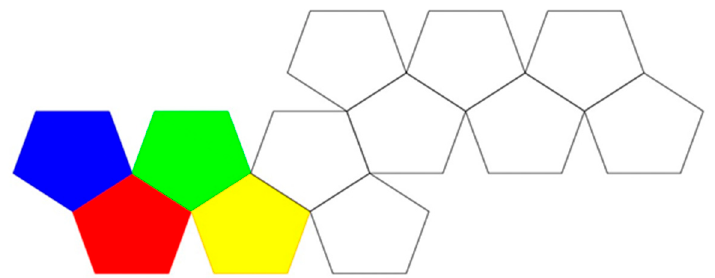
Figure 24. This Dürer is colored to illustrate the order of difficulty of folding at an edge between two individual polygons within the net. The left most blue panel will lift and fold to the inner green panel to its right and the bottom left red panel will lift and fold to the inner yellow panel to its right simultaneously in a true parallel self-folding.